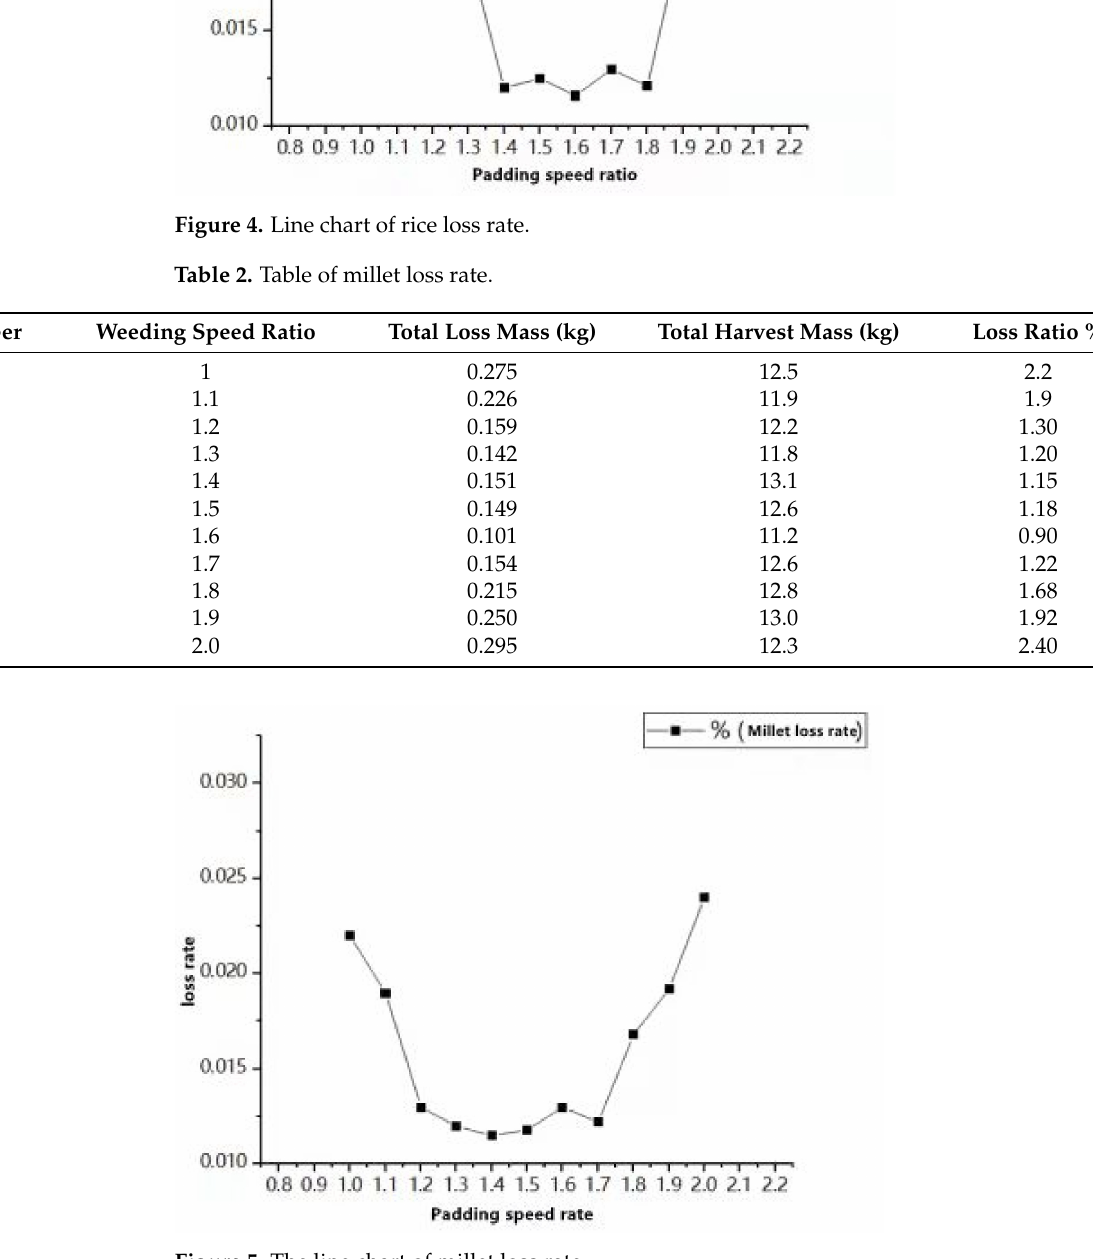
Figure 5. The line chart of millet loss